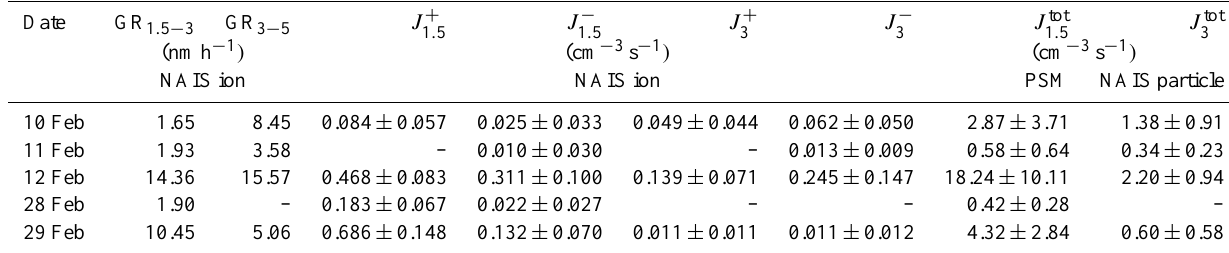
Table 2. Summary of the particle formation event characteristics. GR 1 . 5 − 3 and GR 3 − 5 are the particle growth rates in 1.5–3 and 3–5nm size ranges respectively, J ± and J ± are ion formation rates at 1.5 and 3nm and J tot 1 . 5 3 rates during the event. Instruments used for the calculation of each parameter are specified in the third row; for the NAIS also the mode used for the measurements is given. February 2012, Puy de Dôme.